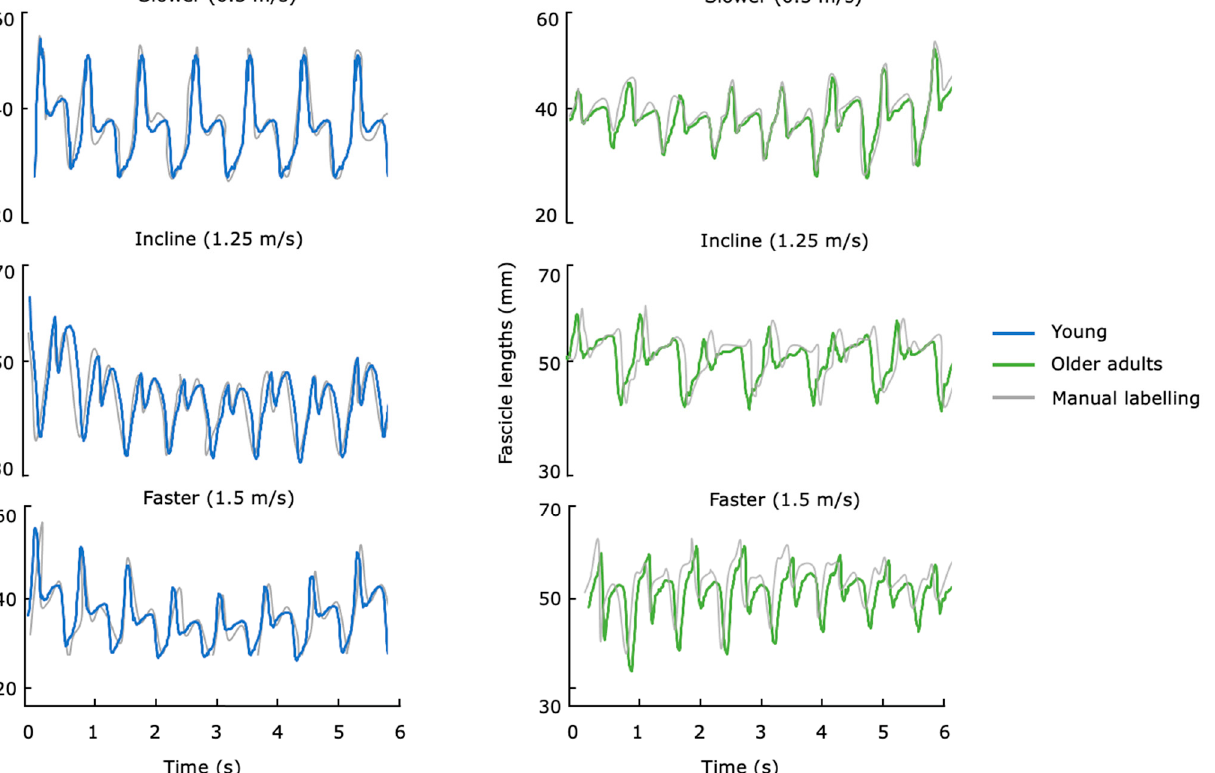
Table 1. Comparison of the performances of the two proposed ResNet + 2x-LSTM algorithms for young-age-trained and all-age-trained models. The table indicates the value of the coefficient of de- termination ( R 2 ), the root-mean-square error (RMSE) in millimeters (mm), the mean absolute per- centage error with respect to the total length of the fascicles (in %), the average absolute frame dif- ference ( aaFD ) of the individual subsegments in mm, and the average detection time (mean in sec- onds ± SD). Performance Metrics